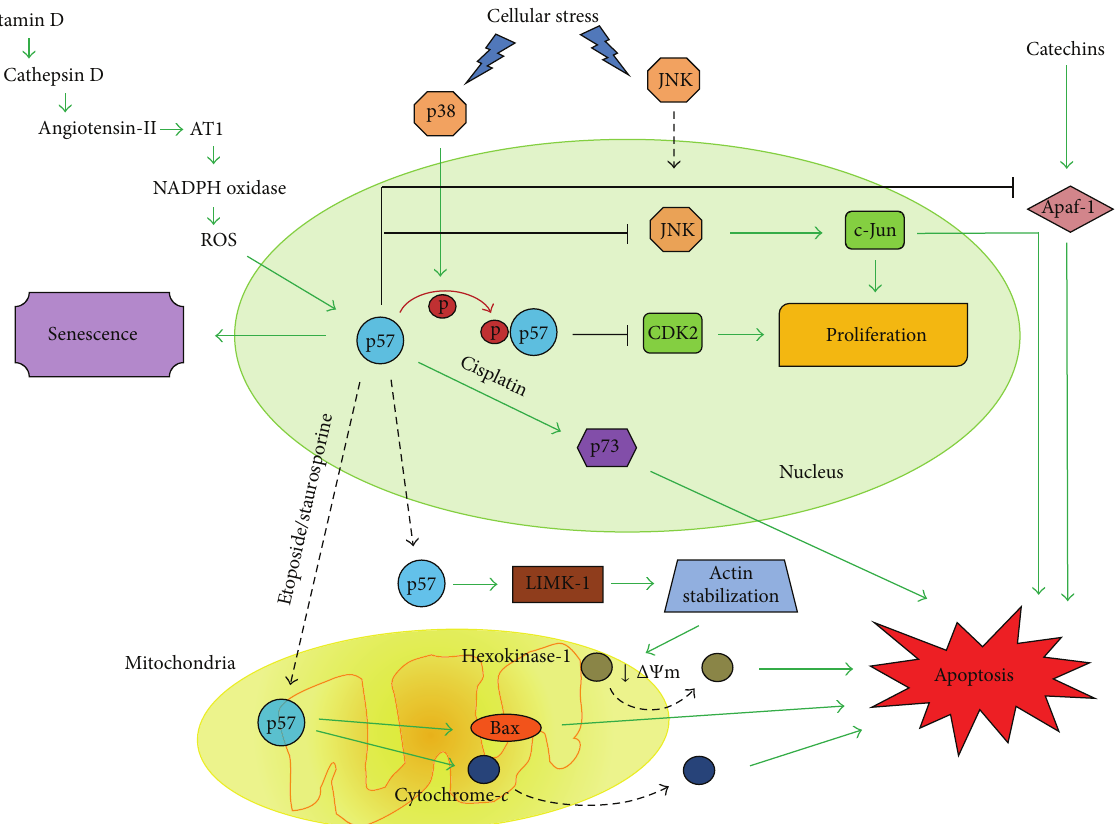
Figure 2: Network of p57 pathways involved in the cellular response to stress. Schematic view of the different mechanisms by which p57 can modulate proliferation, apoptosis, and senescence. Green arrows indicate positive regulation; black T-bar arrows indicate negative regulation; black dotted arrows indicate translocation; red arrow indicates phosphorylation; black facing-down arrow indicates loss of mitochondrial transmembrane potential ( ΔΨ